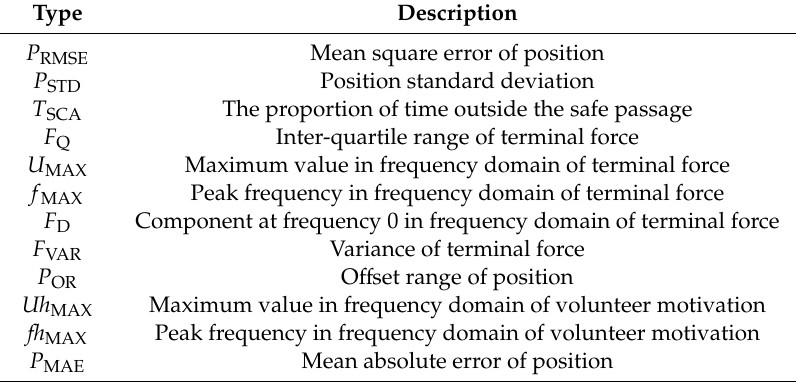
Table 1. Characteristic parameters of volunteer